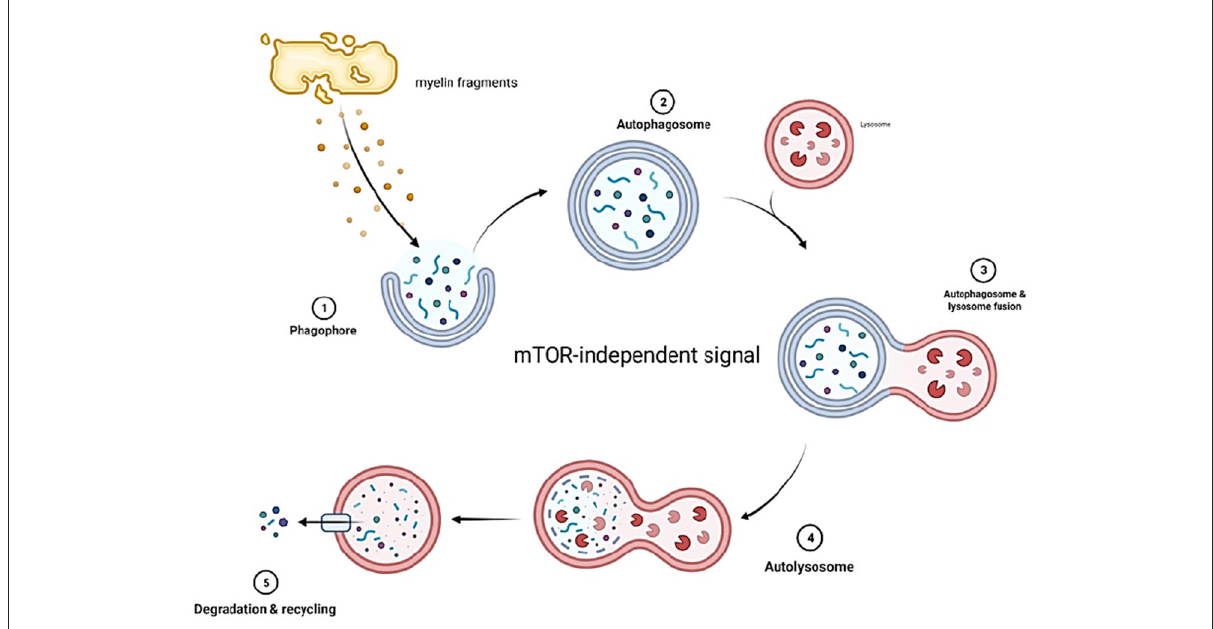
FIGURE3 Myelin fragments at the site of injury form phagophores which develop into autophagosomes. The autophagosomes then fuse with lysosomes that contain enzymes capable of digesting myelin fragments. The decomposed fragments are then released into circulation. Autophagy in SCs is mTOR